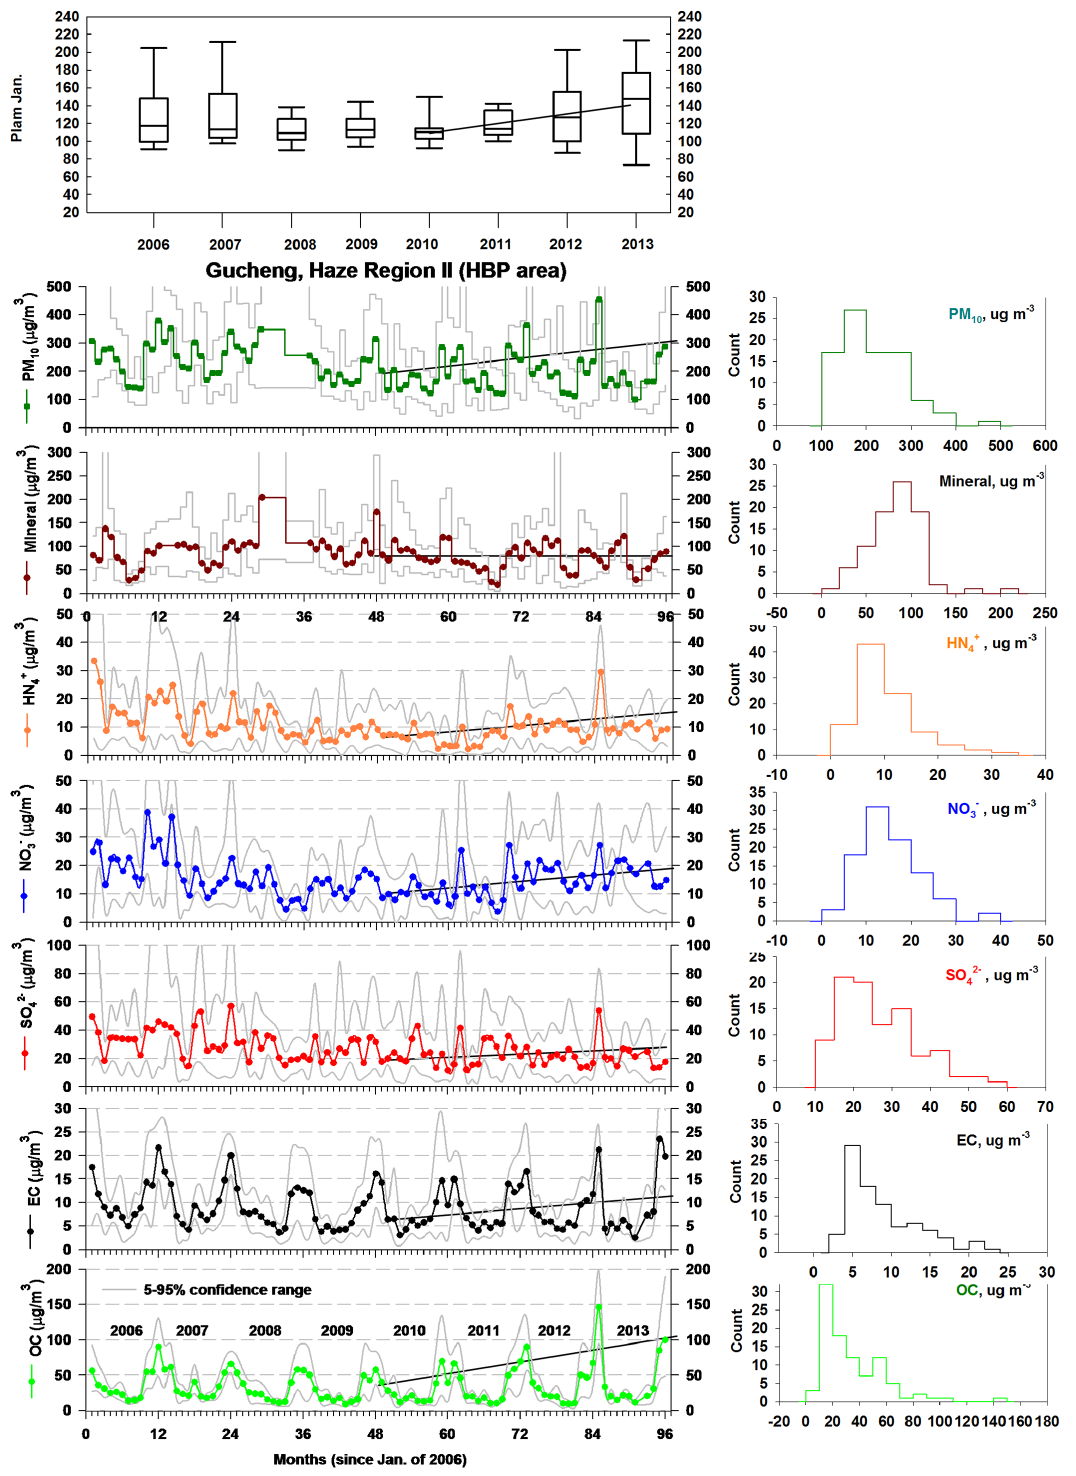
Figure 3. Left panel: change of monthly median concentrations of major chemical components, PM 10 , and January PLAM at Gucheng in haze region II, one of the major haze region in the Hua Bei Plain (HPB) area in China. Wintertime data were used in linear trend fitting from 2010 to 2013; right panel: histogram analysis for various chemical